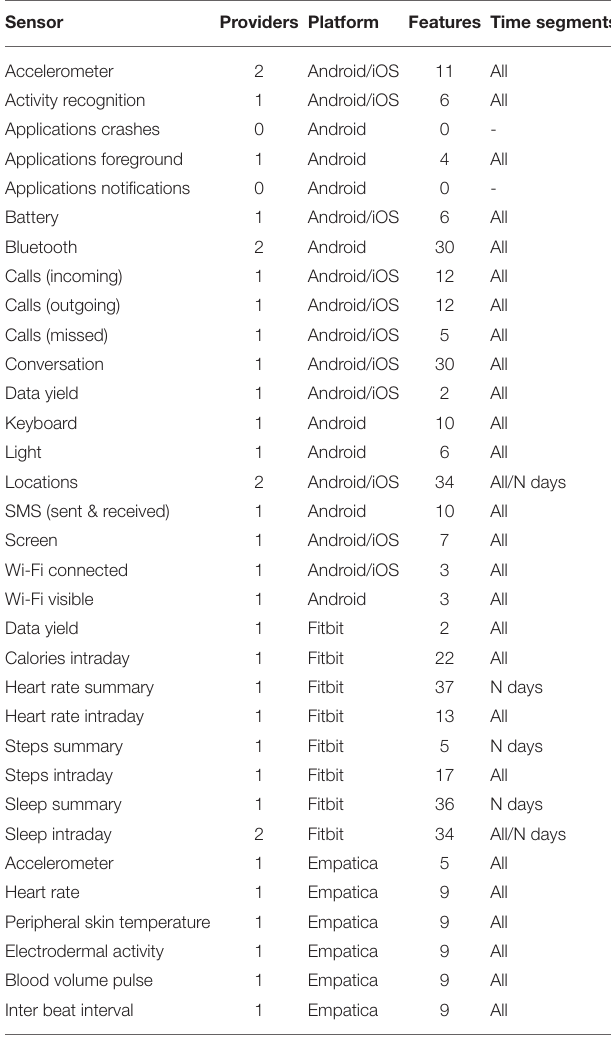
TABLE 1 | Number of behavioral features supported in RAPIDS. Sensor Providers